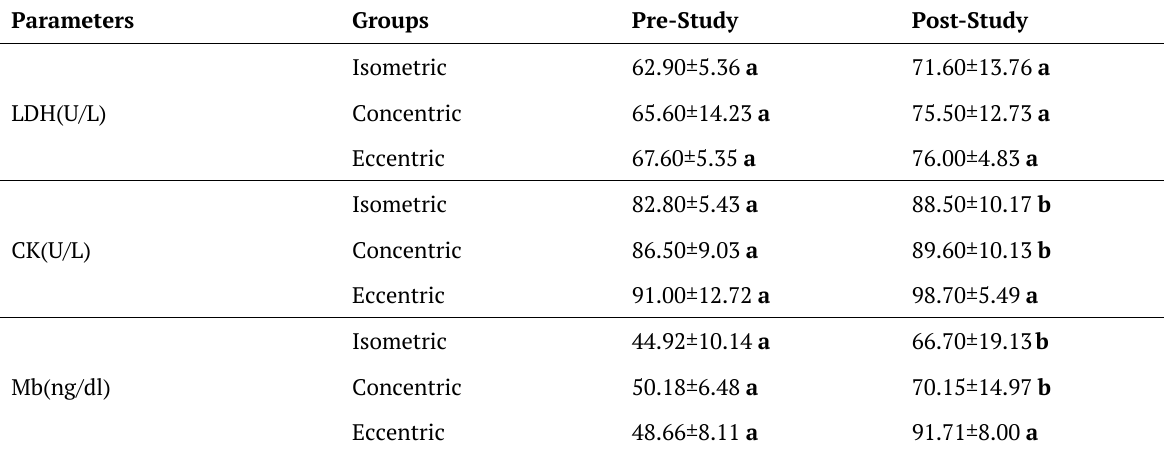
Table 4. Comparison of Serum LDH, CK and Myb levels before and after the study period between groups